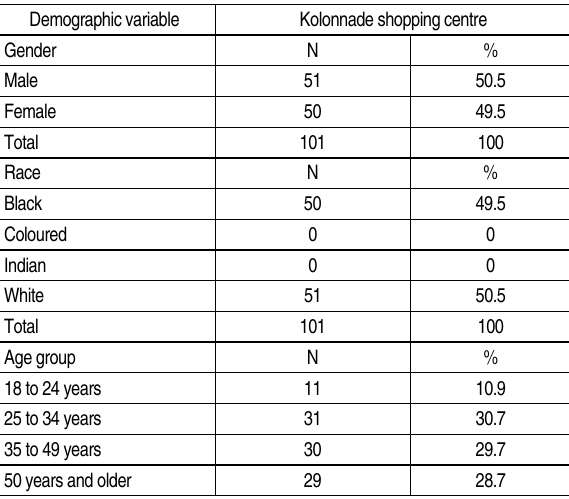
Table 2. Demographic profile of